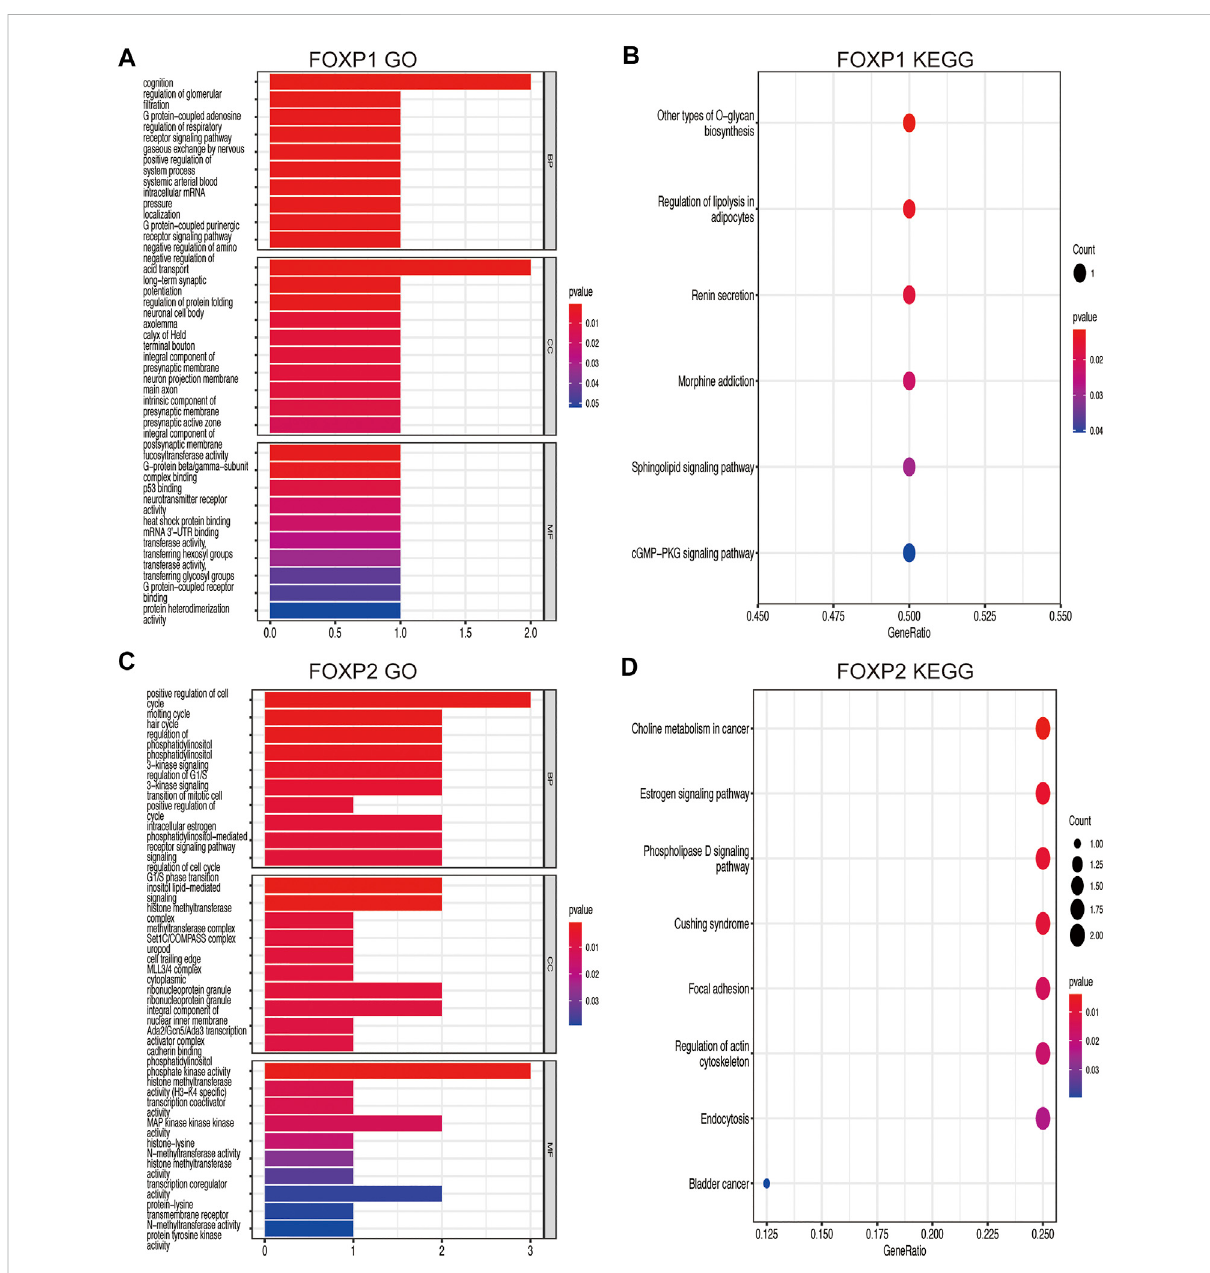
FIGURE 6 GO functional and KEGG pathway enrichment analyses were performed on the coexpressed genes. (A) The GO functional enrichment analysis result on the coexpressed genes of FOXP1 using three annotation systems (BP; CC; MF). (B) The KEGG pathway enrichment analysis result on the coexpressed genes of FOXP1. (C) The GO functional enrichment analysis result on the coexpressed genes of FOXP2. (D) The KEGG pathway enrichment analysis result on the coexpressed genes of FOXP2. (BP, Biological process; MF, Molecular function; CC, Cellular